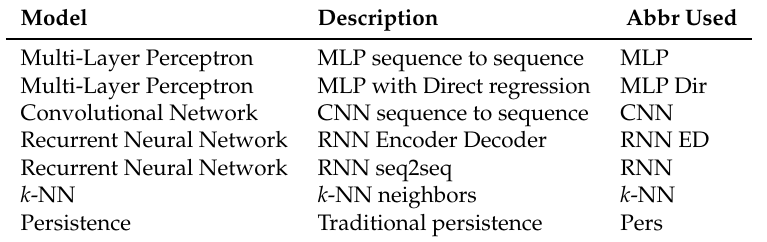
Table 1. Models developed in the experiments with short description and abbreviation used in article. Model